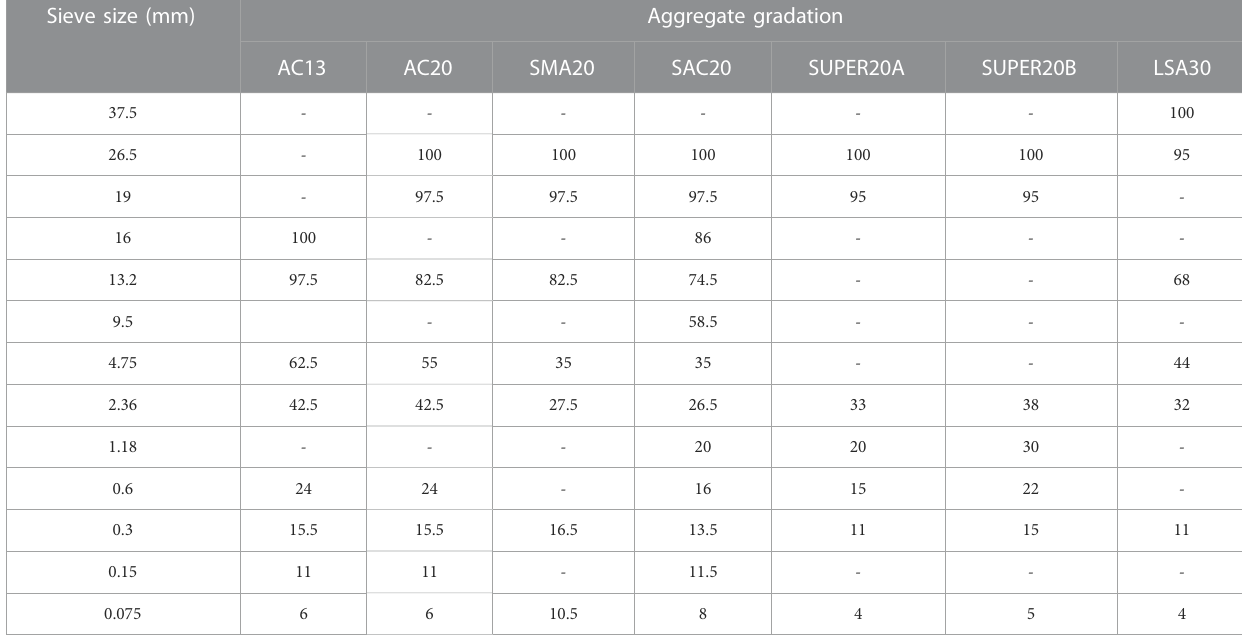
TABLE 3 Aggregate gradation of asphalt